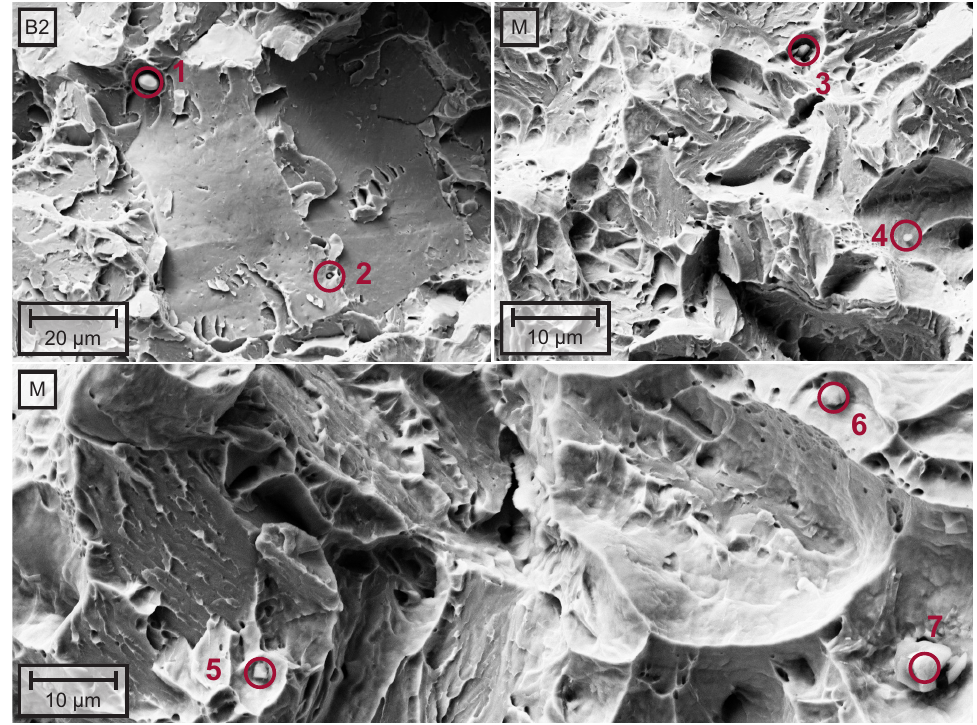
Figure 10. Fracture surface of Charpy V-notch impact test samples: Observed particles which were investigated with EDX, consecutively. Table 2. Chemical composition determined with EDX measurements. All concentrations are given in